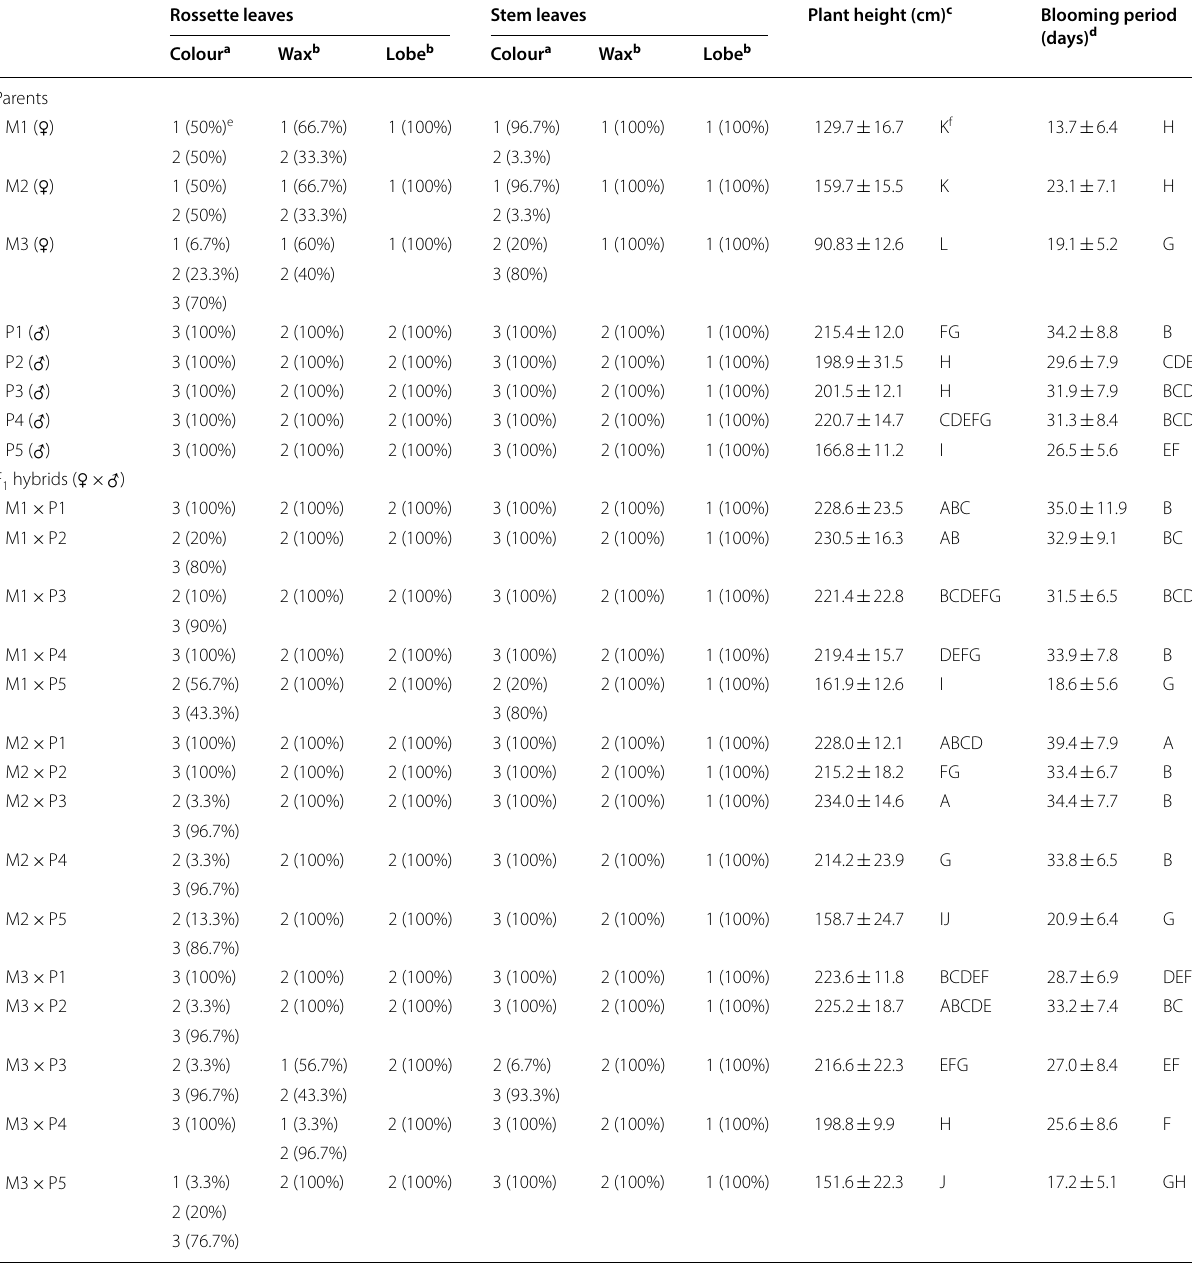
Morphology of “Nongxing 80 days” (M1), “Wansheng rape” (M2), “Edible rape” (M3), “Deza oil No. 18” (P1), “Gueiza No. 4” (P2), “Zhong oil No. 36” (P3), “Wan oil No. 25” (P4), “FTHEB 1001” (P5) varieties, and the resultant F 1 hybrids were investigated in the field a Rosette and stem leaf colour were grouped by RHS Colour Chart: 1 (shine green/143A), 2 (dull green/138B), and 3 (dark green/137A or N137A) b